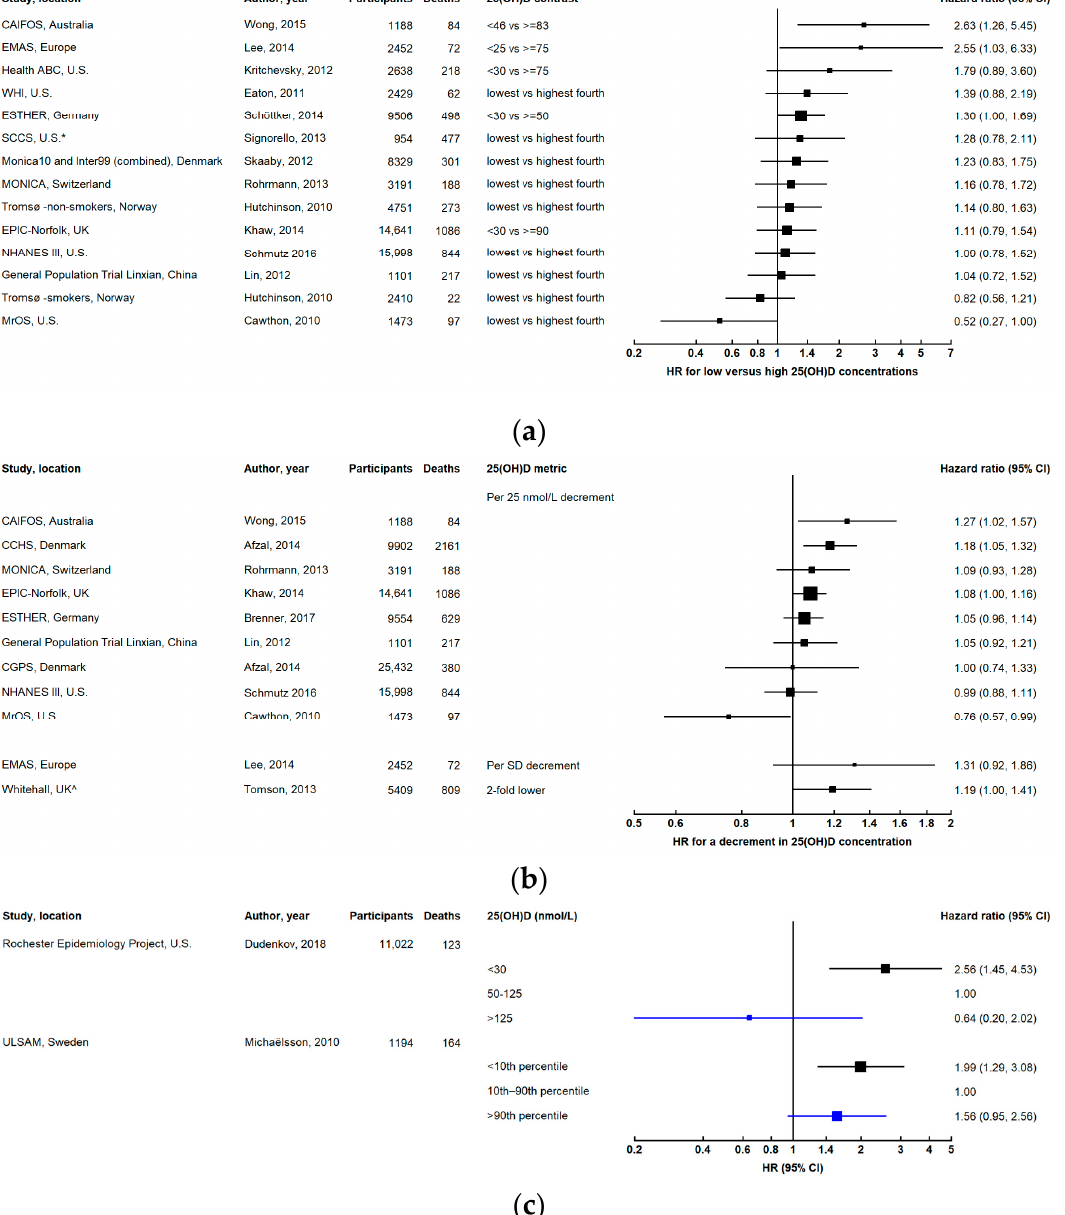
Figure 4. Results from prospective studies investigating cancer mortality in relation to 25-hydroxyvitamin D (25(OH)D) concentration: ( a ) comparing low versus high concentrations categorically; ( b ) continuously, for a decrement in 25(OH)D concentration; ( c ) low (black) and high (blue) concentrations compared with levels in the middle of the 25(OH)D distribution. The squares represent hazard ratios and horizontal lines are the 95% confidence intervals. Studies that estimated odds ratios or relative risks are denoted by * and ˆ, respectively. Axes are scaled differently in each panel to maximize the visualization of effect estimates.